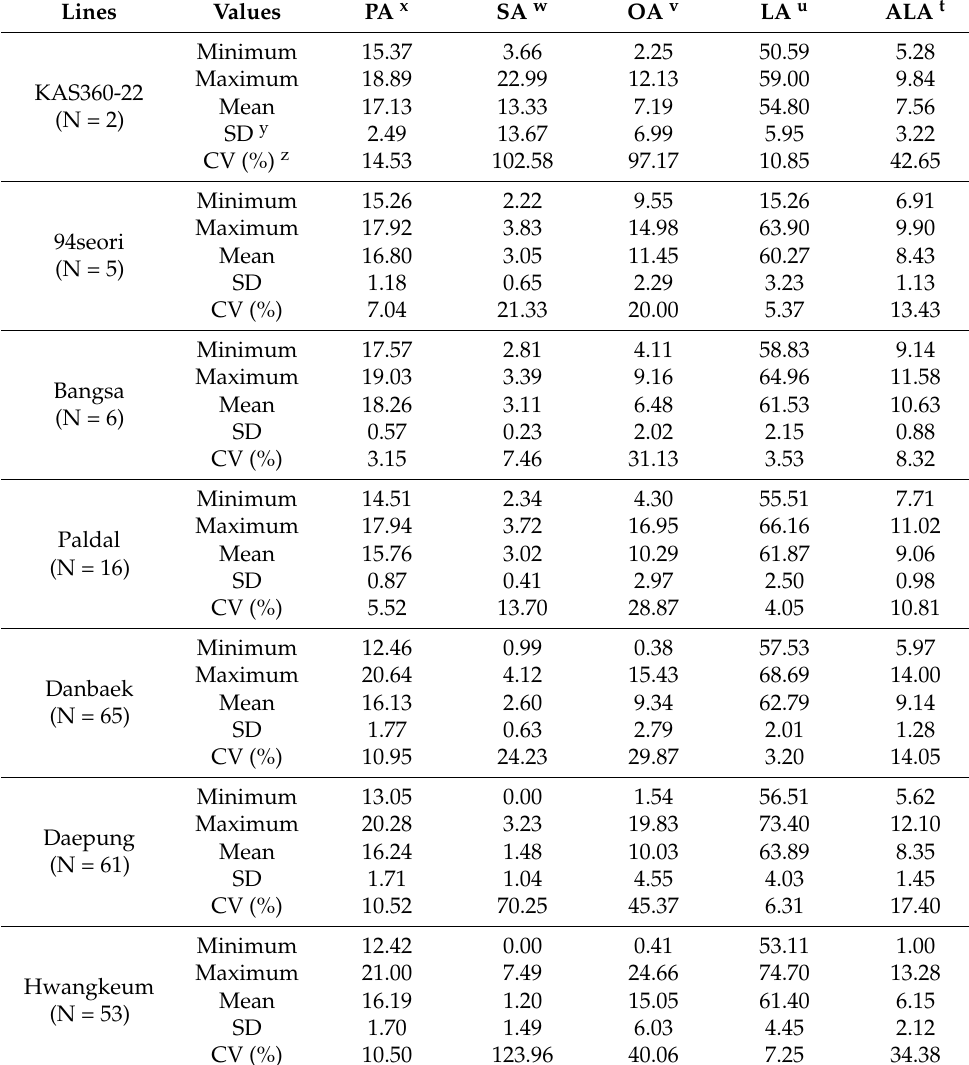
Table 2. Variation of fatty acid contents (%) in seeds of 208 soybean MDP